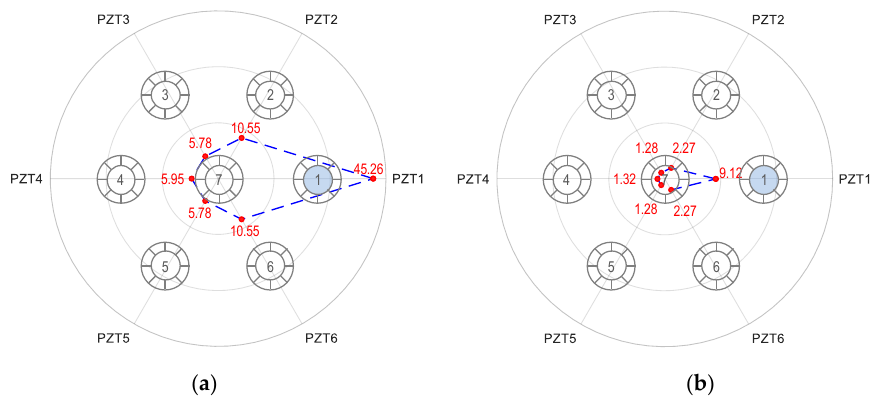
Figure 14. Linear tomography of RMSD indices (%) using all PZTs 1–6: Strand 1 breakage. ( a ) Peak 1’s impedance and ( b ) Peak 2’s impedance.